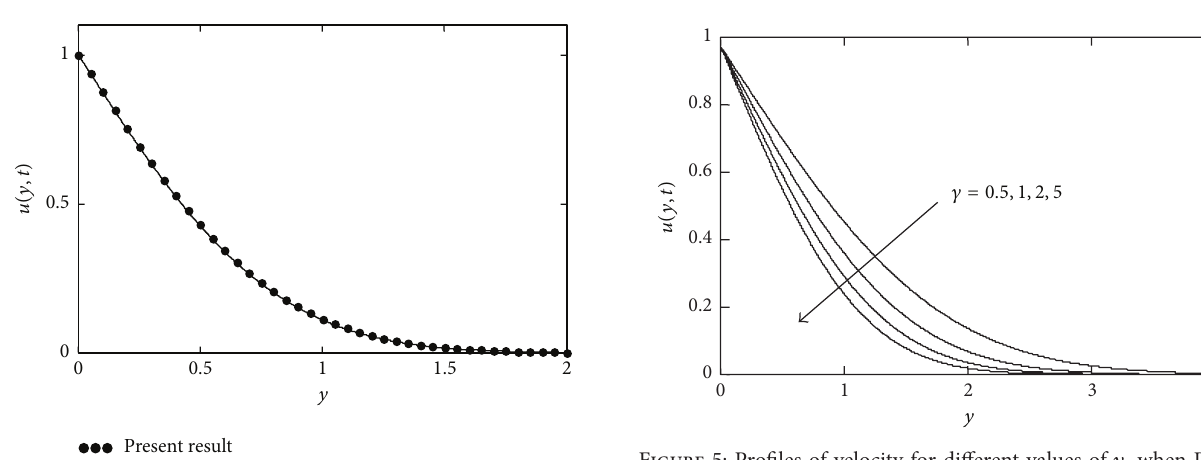
Figure 5: Profiles of velocity for different values of 𝛾 , when Pr = 0.3 , Gr = 0 , 𝑡 = 0.3 , and 𝜔 = 𝜋/4 .